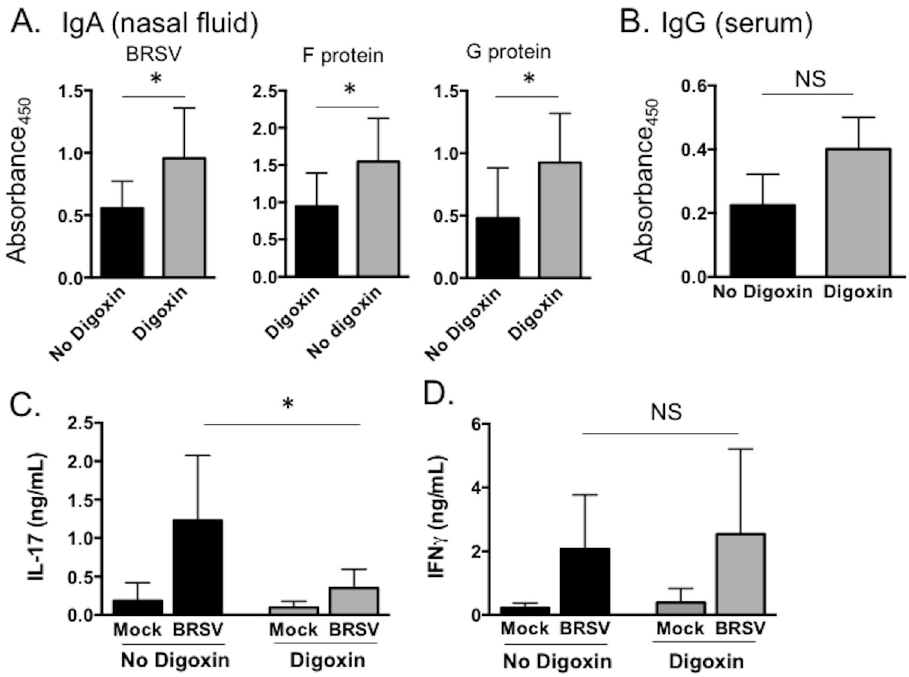
Fig 7. Therapeutic inhibition of IL-17 production alters the mucosal immune response to BRSV infection. ( A ) Nasal fluid samples were collected on day 10 post infection and analyzed for BRSV-specific IgA by indirect ELISA. ( B ). Serum samples were collected on day 10 post infection and analyzed for BRSV-specific IgG by indirect ELISA. (C and D ) Bronchoalveolar lavage samples were collected during the necropsy on day 10 post infection. BAL cells were stimulated for 72 hours with BRSV, or remained unstimulated, as in B. Cell culture supernatants were collected and concentrations of ( C ) IL-17 and ( D ) IFN γ were measured by commercial sandwich ELISA. Data represent means ± SEM. � p < 0.05 as determined by Kruskal-Wallis test, followed by Dunn’s multiple comparisons test.